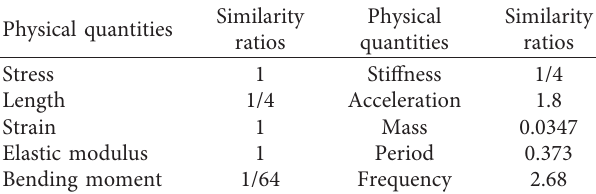
Table 1: Scaling factors of the model